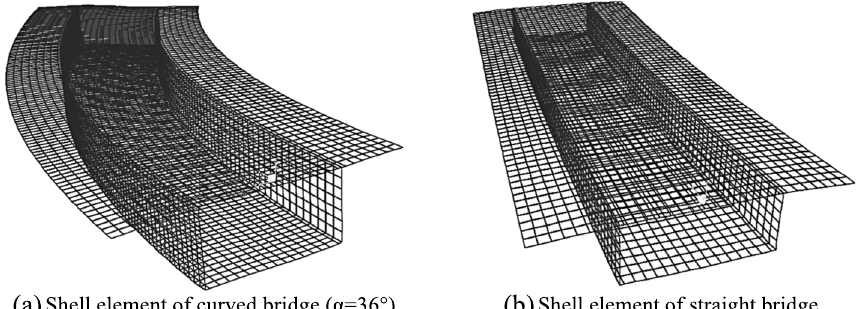
Fig. 8 Finite element model of box-girder bridge. a Shell element of curved bridge (α of straight bridge